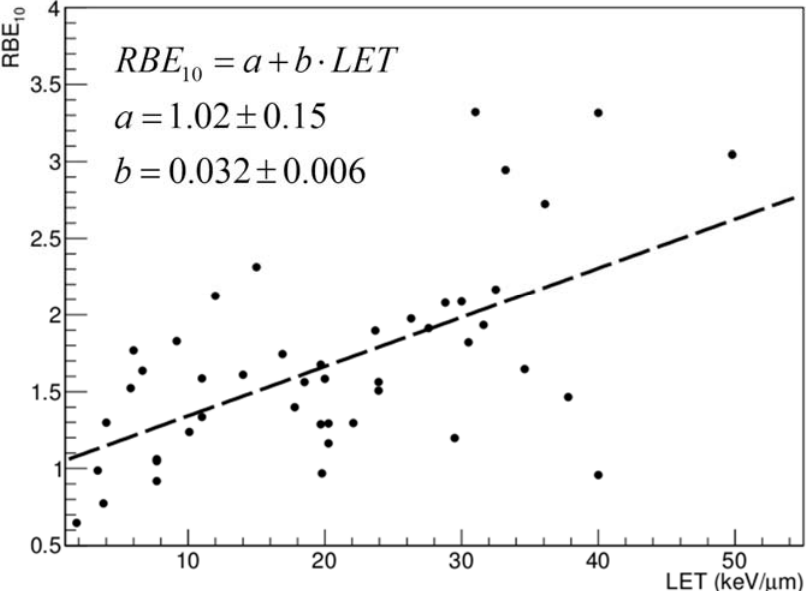
Figure 2. RBE values for 10% survival, as extracted from PIDE [7]. The dashed line shows the tendency to an increase in RBE with LET and is the result of a linear fit. All values extracted from the database were pooled together, independent of α / β